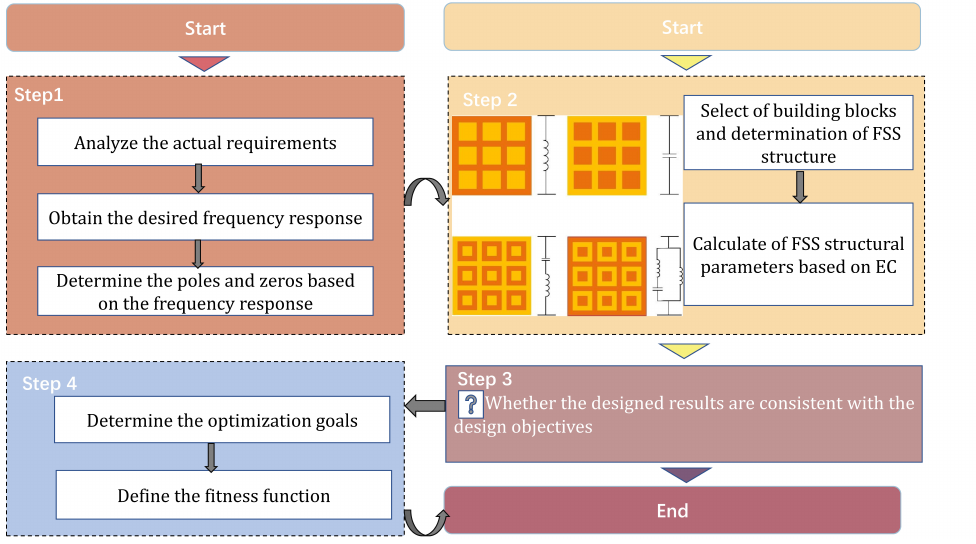
Figure 2. Flow chart of the proposed